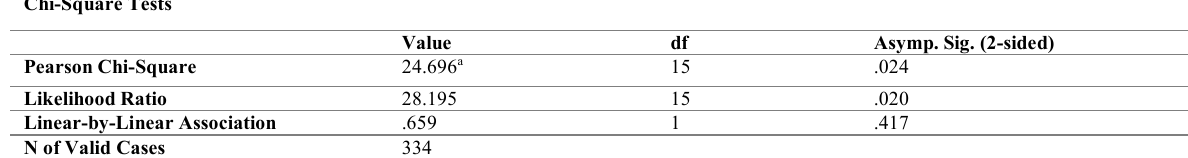
Table 7 : Chi-Square Test for AUDIND and Firm Performance